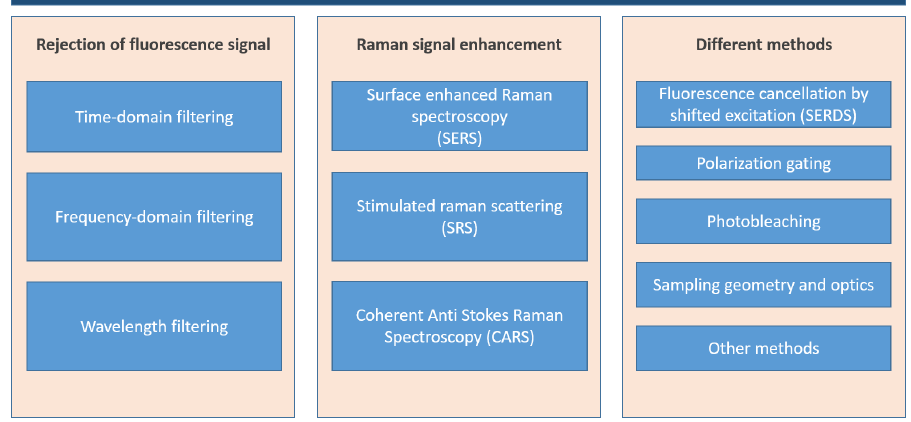
Figure 1. Graphic classification of methods for Raman enhancement regarding fluorescence